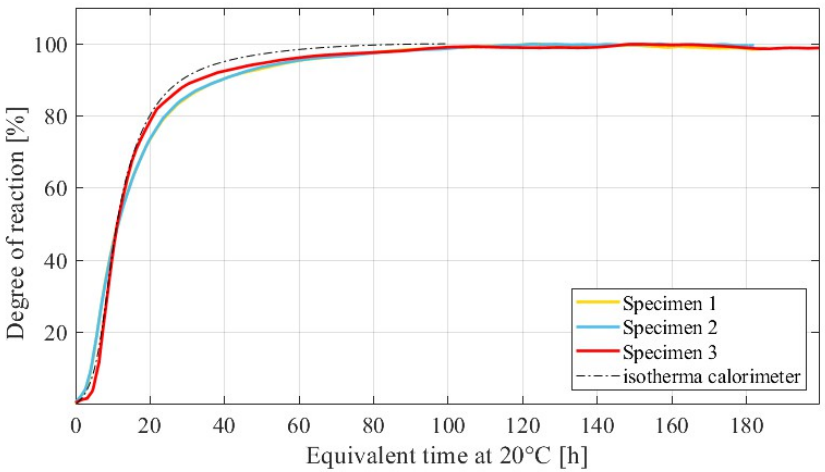
Figure 6. Comparison between Degree of reaction − Equivalent Time curves from SAC and isothermal calorimetric tests on UHPC specimens.